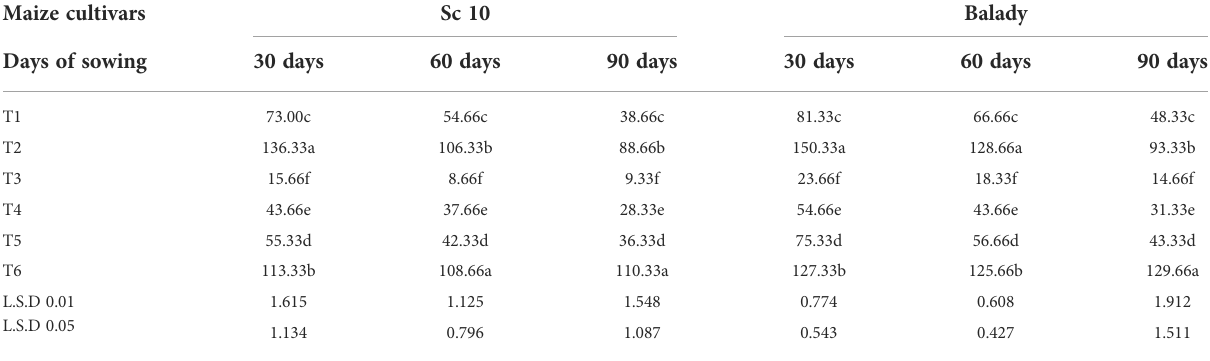
TABLE 2 Fusarium verticillioides frequency from soil under different treatments at different times after sowing during the 2020 growing season. Maize cultivars